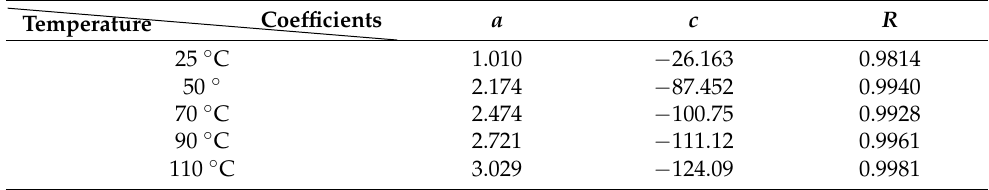
Table 3. Linear regression result of the relationship between the dynamic elastic modulus and static elastic modulus of #5 rock